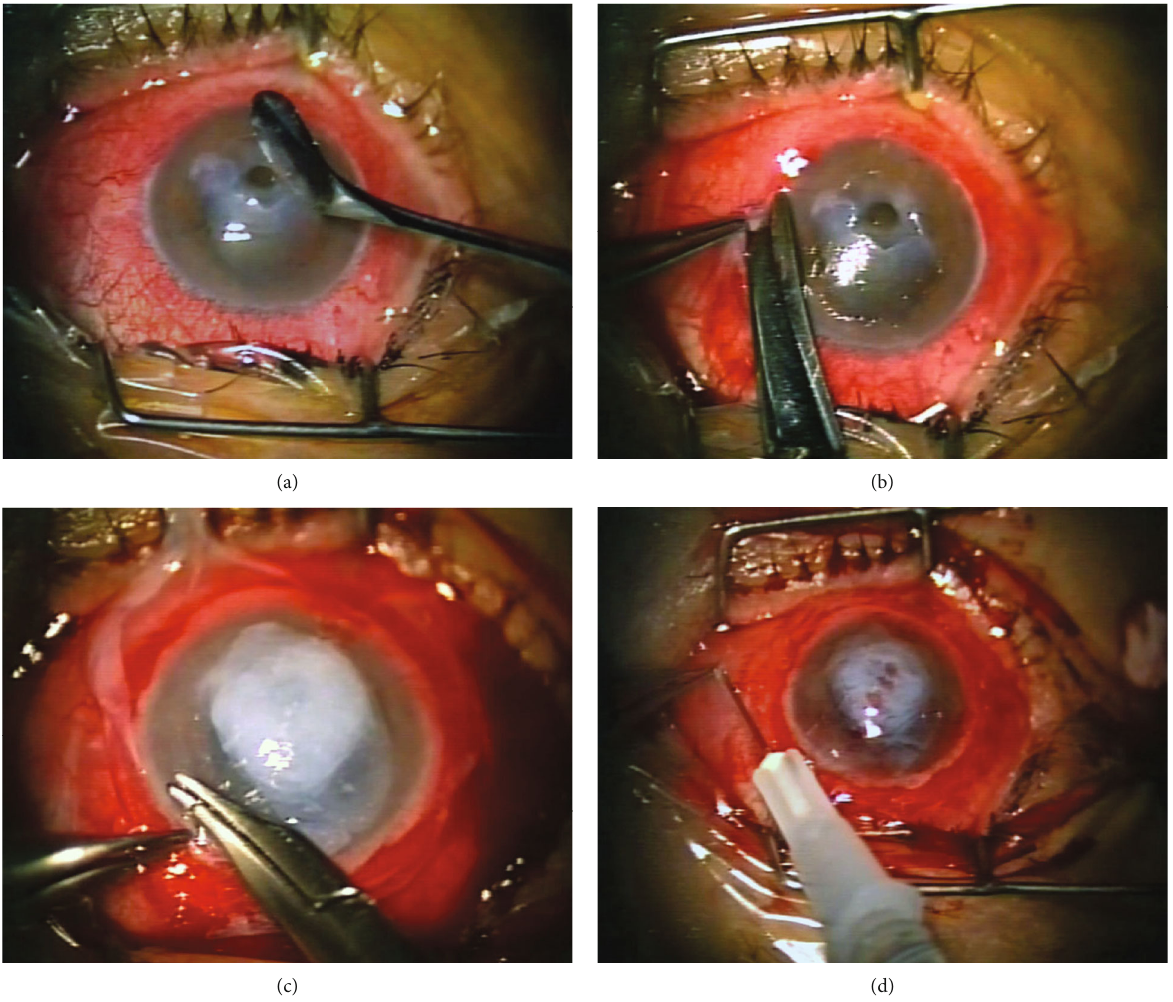
Figure 1: (a) The stromal ulceration was debrided, and the corneal epithelium was removed up to the limbal area. (b) 360 ° conjunctival peritomy is performed adjacent to limbus. (c) The ulcer was fi lled up to a surface level with multiple pieces of AM, and a larger AM was transferred to the recipient eye with the epithelial side down. The membrane was trimmed to cover the cornea and limbal area and secured with continuous 10-0 nylon sutures to the conjunctival edges. (d) After suturing, we do a subconjunctival injection with a mixture of dexamethasone and gentamycin. Finally, we place a bandage contact lens to cover the transplanted membrane and